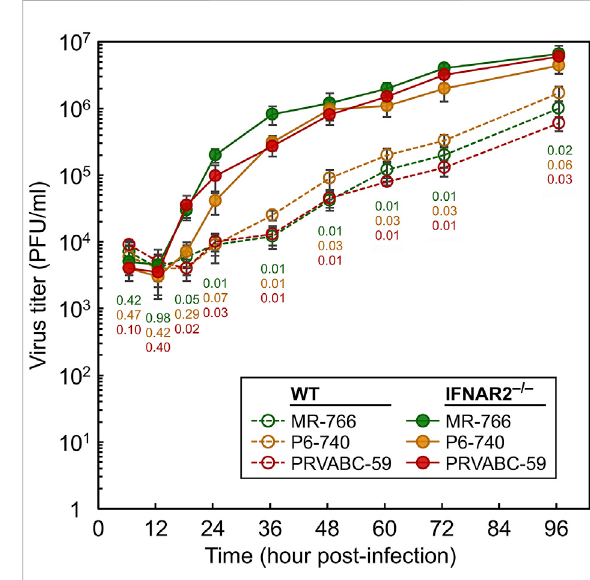
FIGURE 4 qRT-PCR analysis of fi broblast responses to human IFNA. Data were normalized using the average expression of four housekeeping genes. The IFNAR1/2 − / − group ( IFNAR1 − / − and IFNAR2 − / − sheep) differed signi fi cantly from WT and IFNAR2 +/ − sheep for MX1 , MX2 and ISG15 ( p < 0.01) using pairwise comparisons with Student ’ s t -test.